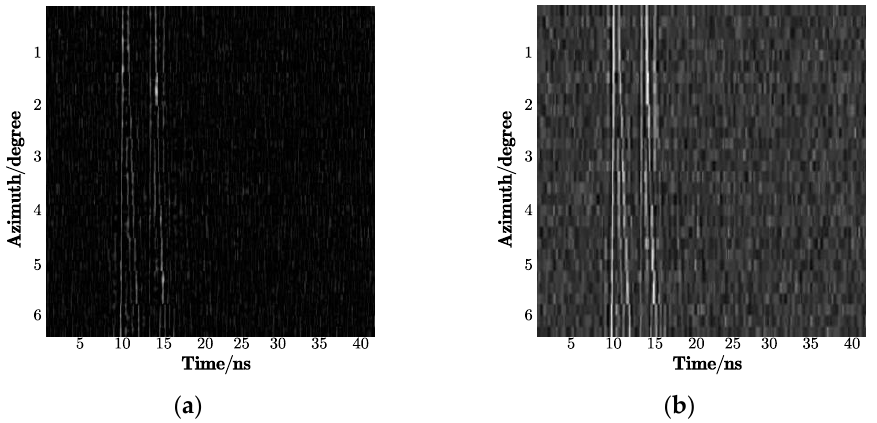
Figure 12. Decomposition results: ( a ) 2D empirical mode decomposition (2D-EMD) and ( b ) 2D-Wavelet.